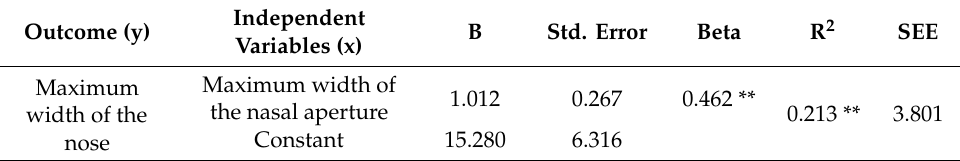
** Indicates significance at the 0.01 level.